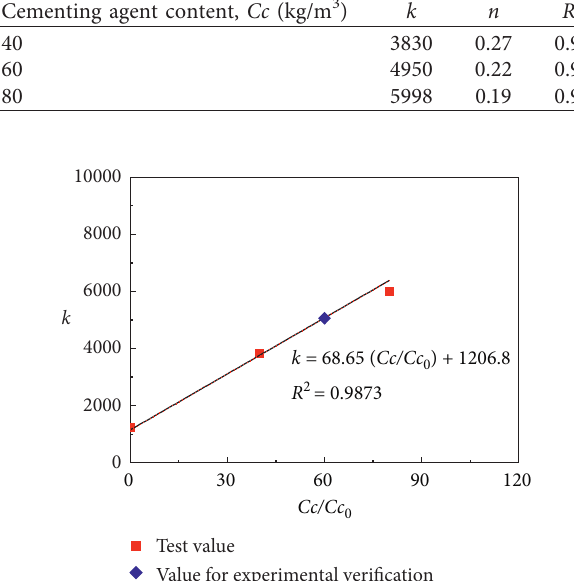
Figure 8: Relation between k and the cementing agent contents.